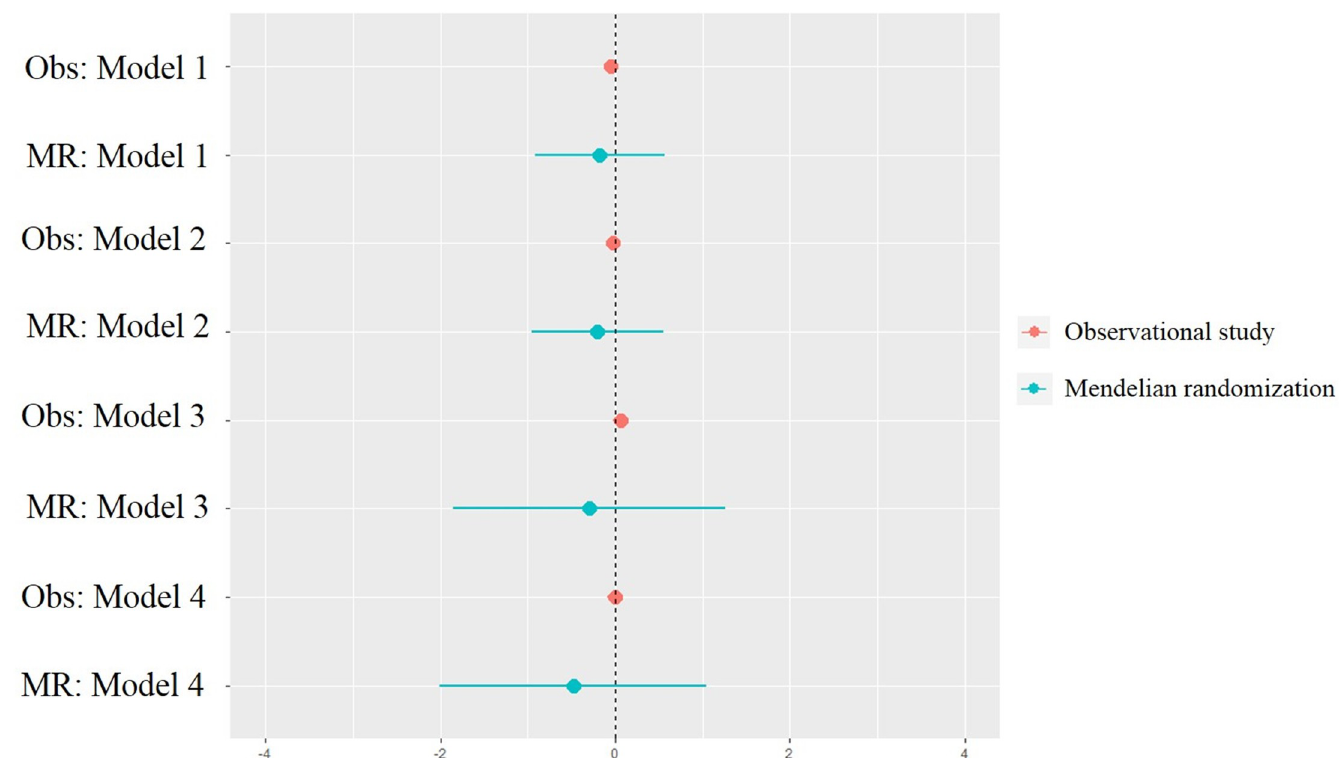
Fig 1. Forest plot of observational analysis and Mendelian randomization analysis. Observational analysis, Obs; Mendelian randomization analysis, MR.